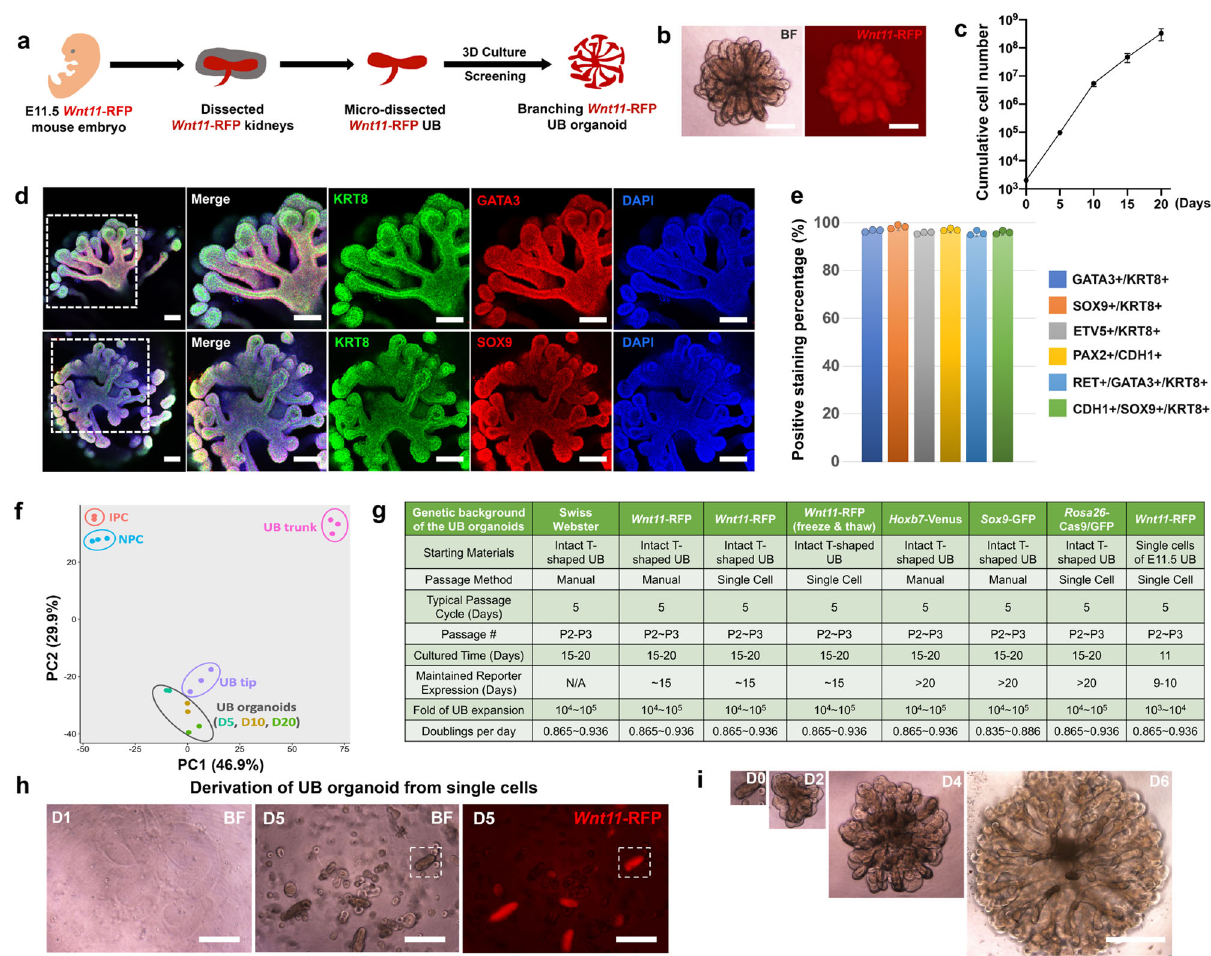
Fig. 1 Expanding mouse UB progenitor cells into 3D branching UB organoids. a Schematic of mouse UB isolation and screening for UB organoid culture condition. b Representative bright fi eld (BF, left panel) and Wnt11 -RFP (right panel) images of UB organoid. Scale bars, 200 µ m. c Cumulative growth curve of UB organoid culture starting from 2000 cells. Each time point represents three biological replicates. d Whole-mount immunostaining of UB organoid for various UB markers at Day 10 of culture. The four panels on the right represent the boxed region in the left panel. Scale bars, 100 µ m. e Quanti fi cation of percentages of UB cells stained positive for different UB markers in Fig. 1d and Supplementary Fig. 2a, b. Each column represents counts from three different fi elds of view ( n = 3). f Principal component analysis (PCA) of RNA-seq data. Different colors and oval circles represent different primary kidney cell populations (NPC, IPC, UB tip, and UB trunk) or UB organoids cultured for 5 (D5), 10 (D10), and 20 days (D20). g Summary of UB organoid derivation from mouse strains with different genetic backgrounds or with different derivation methods. h Bright fi eld (BF) images showing single UB cells, derived from Wnt11 -RFP mice, cultured in the UBCM on Days 1 (left panel) and 5 (middle panel), as well as Wnt11- RFP image on Day 5 (right panel). Scale bars, 200 µ m. i UB organoid derivation from a single UB cell-derived budding structure isolated from the boxed region in ( h ) at Days 0 (D0, the day of isolation and re-embedding into Matrigel), 2 (D2), 4 (D4), and 6 (D6). All images in ( i ) have been scaled to share the same scale bar with the D6 image. Scale bar, 400 µ m. All data are presented as mean±s.d. Source data are provided as a Source Data fi